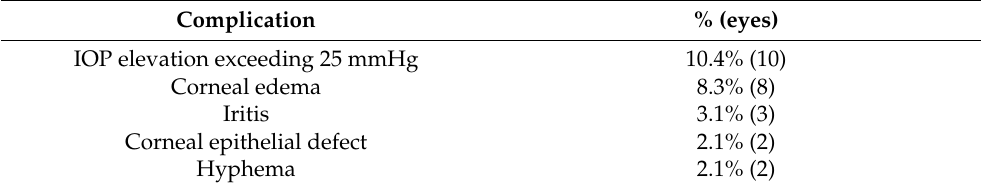
Table 3. Postoperative